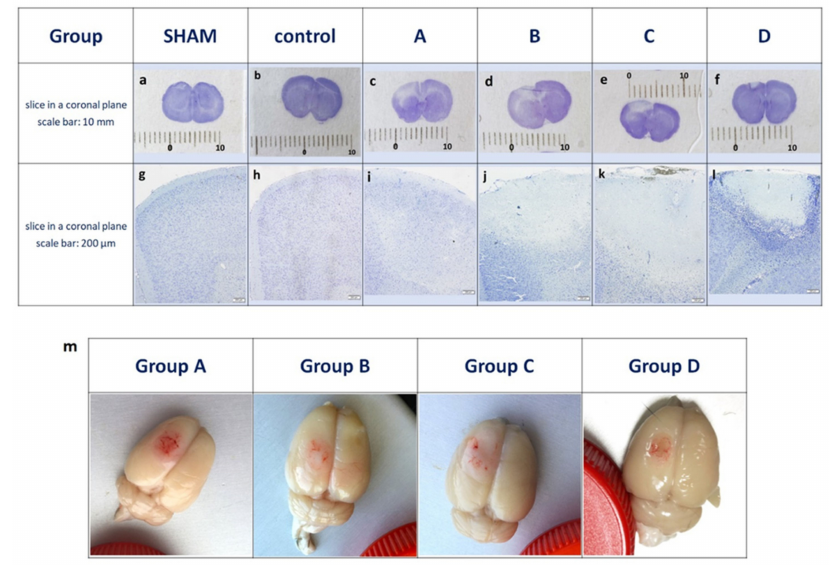
Figure 2. Frontal slices of rat brains following Nissl staining after photothrombotic ischemic stroke. ( c – f ) Pale-stained ischemic lesions in the left hemisphere. The brain tissue damage is visible in Groups A, B, C and D only in the ipsilateral hemisphere where focal ischemia was induced. No damage was reported in the contralateral hemisphere in Groups A, B, C and D. Scale bar: 10 mm; ( i – l ) Ischemic lesions in the area of the left hemisphere cortex in Groups A, B, C and DNissl staining. Scale bar: 200 µ m; ( a , b ) In the SHAM and Control Group no areas of damage are visible in the ipsilateral and contralateral cerebral hemispheres; ( g , h ) Ischemic lesions in the area of the left hemisphere cortex in the SHAM and Control Group. Nissl staining. Scale bar: 200 µ m; ( m ) The above view of the rat brains immediately after euthanasia following ischemic stroke in Groups A, B, C and D. Visible tissue damage in the left